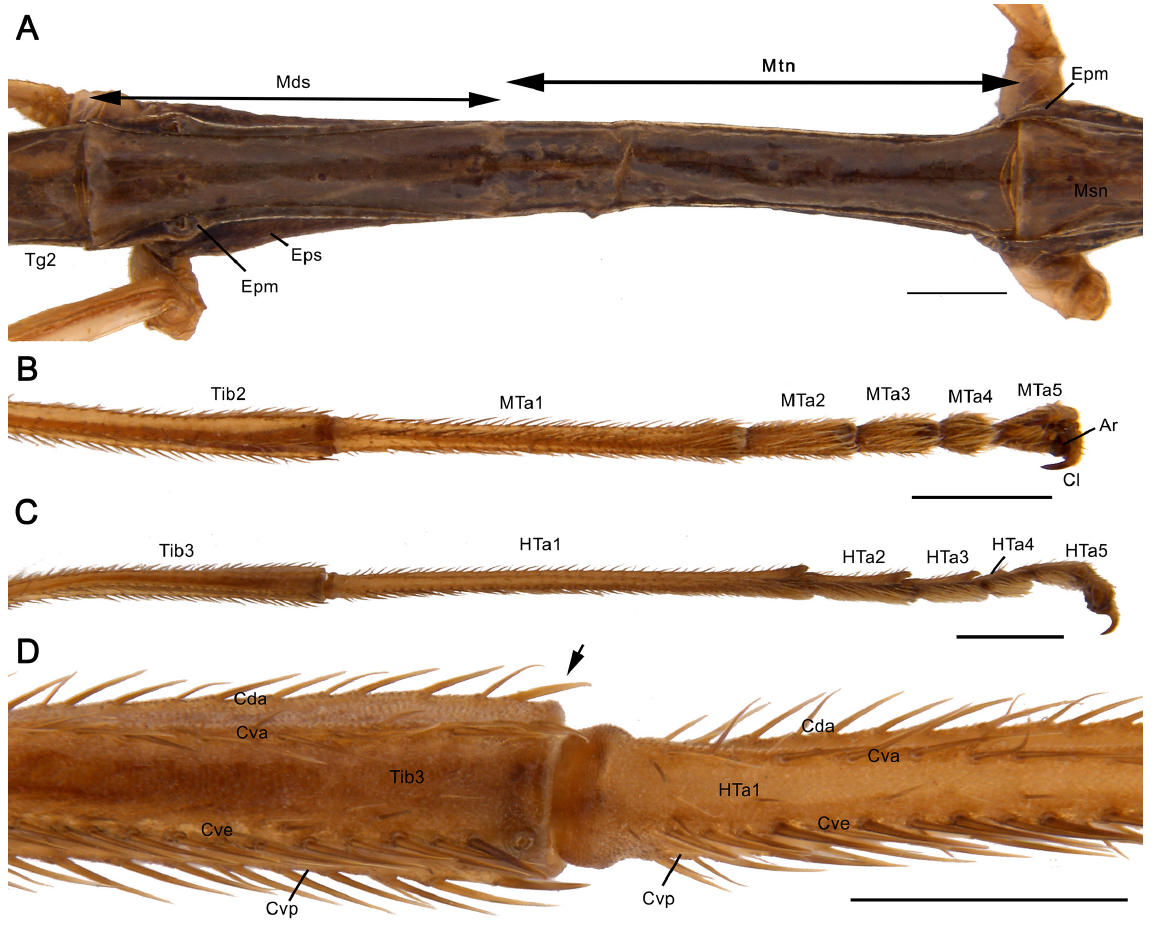
Fig. 31. Arumatia aramatia Ghirotto gen. et sp. nov., paratype, ♂ (MZUSP 1322), thorax and leg morphology. A . Metathorax and median segment in dorsal view, arrows indicate the length of each segment. B . Right mid tarsus, ventral view. C . Right hind tarsus (mirrored), prolateral view. D . Detail of right hind tibia and tarsus (mirrored), latero-ventral view, arrow showing stronger apical spines. Abbreviations: Ar = arolium; Cda = dorsal anterior carina; Cl = claw; Cva = ventral anterior carina; Cve = ventral carina; Cvp; ventral posterior carina; Epm = epimeron; Eps = episternum; HTa = hind tarsomere; Mds = median segment; Msn = mesonotum; MTa = mid tarsomere; Mtn = metanotum; Tg = tergum; Tib, tibia. Scale bars: A–C = 1 mm; D = 0.5